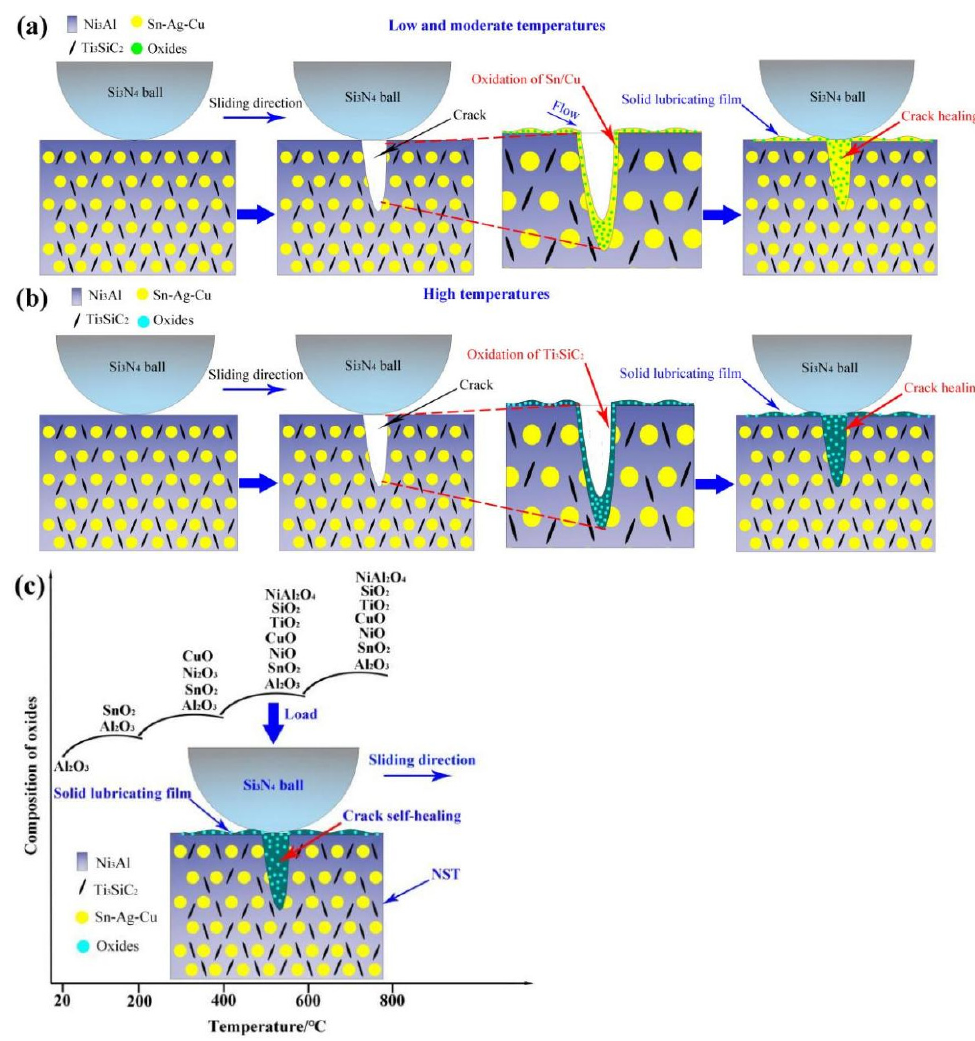
Figure 15. The schematic diagrams of the crack self-healing of wear scars of NST during sliding